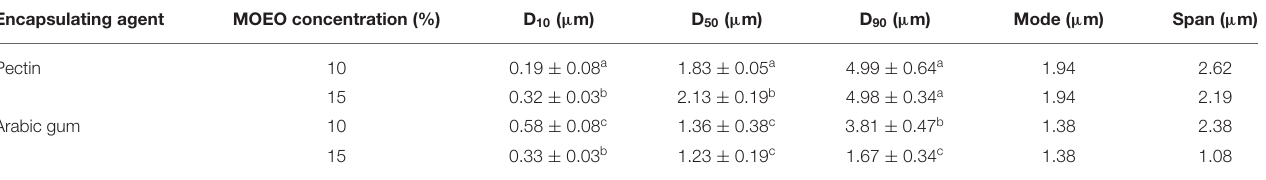
TABLE 3 | Values of particle size distribution of emulsions stabilized with pectin or Arabic gum at concentrations of 10% or 15% w/w of oregano essential oil (MOEO). Encapsulating agent